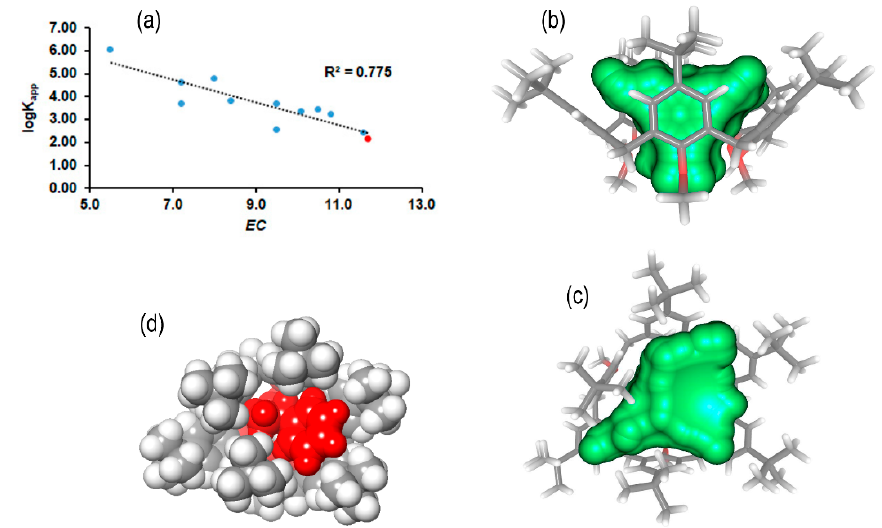
Figure 4. ( a ) Linear regression analysis of log K app vs EC for alkylbenzylammonium-based pseudorotaxane complexes: points colored in light blue represent log K app /EC values reported in reference [38], while in red is indicated the log K app /EC value of the ( endo-chiral )- 2 + @3 complex. ( b , c ) Different views of the final cavity volumes of 3 in cone conformation, upon endo-chiral complexation with 2 + The initial volume of the free host 3 has been calculated considering the calix[6]arene in 1,2,3-alternate conformation, in accord with the protocol reported previously by us [38]. ( d ) Top view of the DFT-optimized structure of ( endo-chiral )- 2 + @3 complex, in red ( S )-( α -methyl-benzyl)benzylammonium axle 2 + guest.